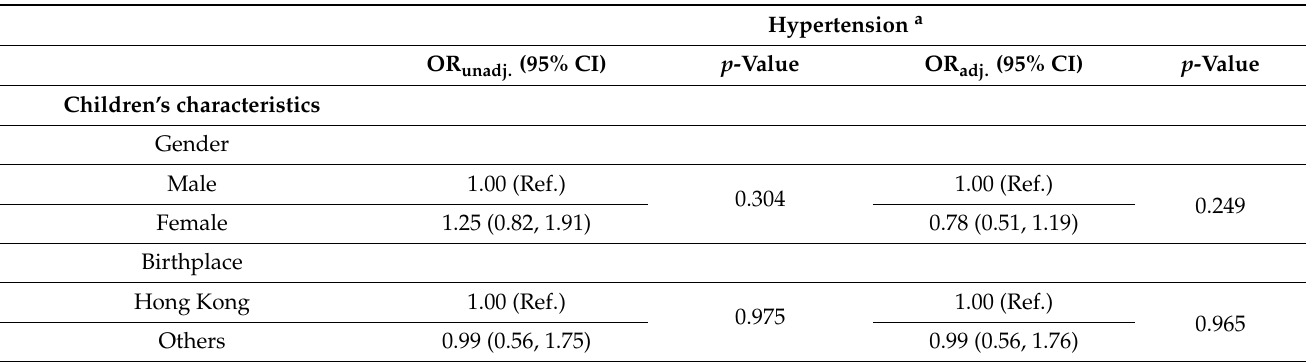
Table 3. Associations between background characteristics and hypertension in children with